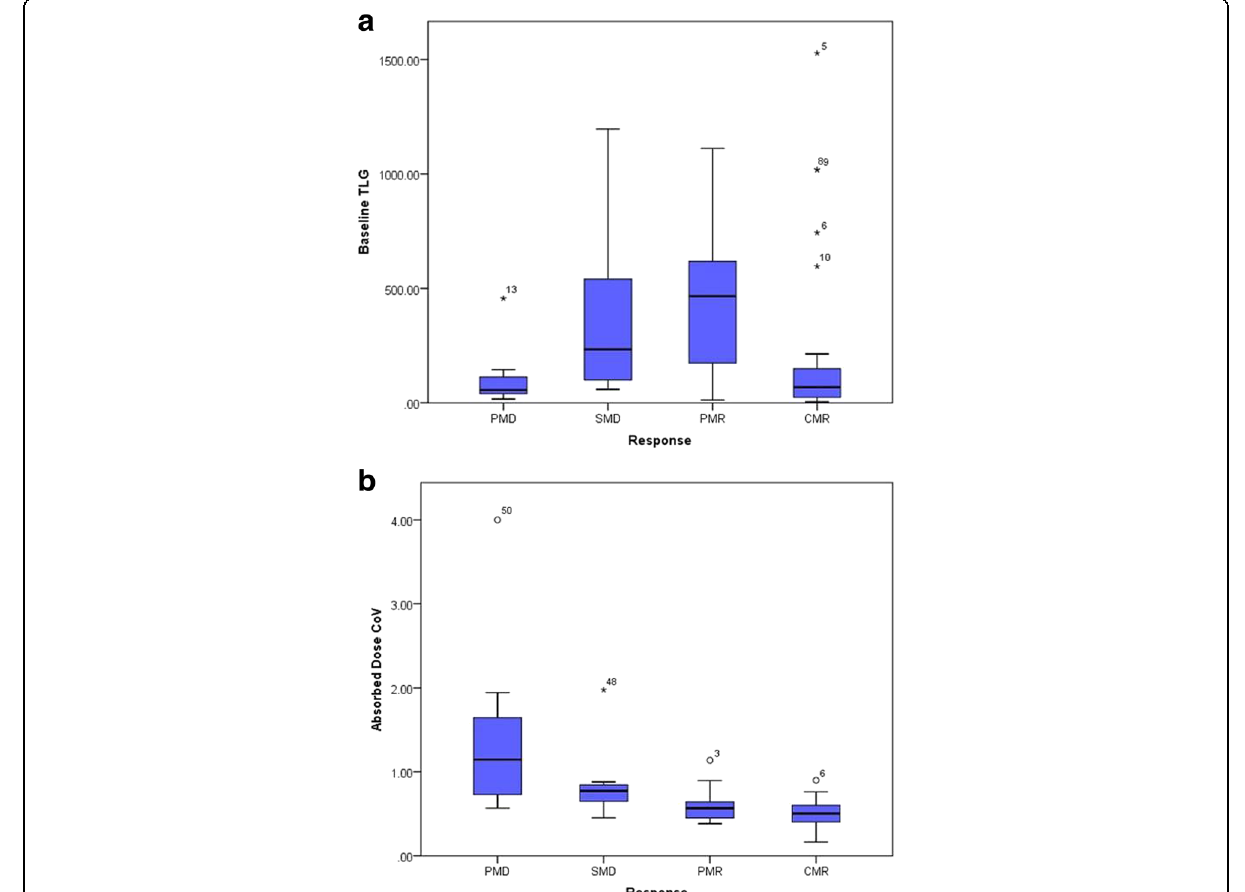
Fig. 6 Baseline TLG ( a ) and Absorbed dose CoV ( b ) of lesions within each response